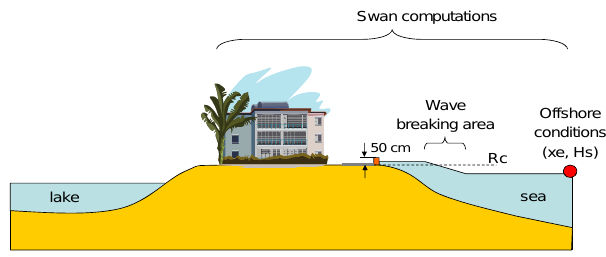
Fig. 2. Site (DEMO City) location with the sea wall position (red line) and observation points (MIR1 and 2) where the inversion cal- culation is performed (a) and photo of the sea wall from point MIR 2 (b) .